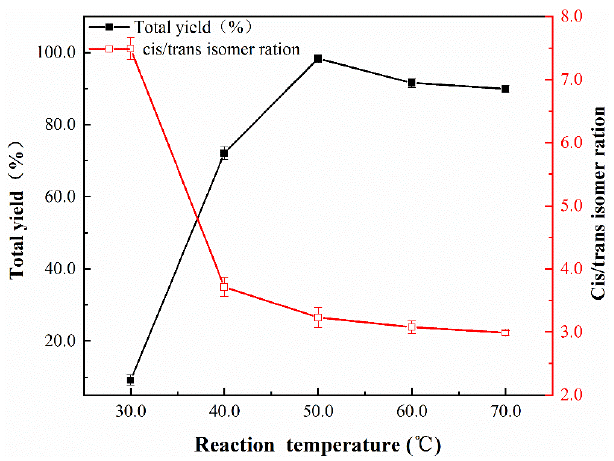
Figure 6. Effect of temperature effect on nano-Fe/Pd catalyst activity in the reaction. Reaction con- ditions: catalyst (10 mg), acetylene (11 mmol), MeOH (20 mL), KI (112 mg), P CO = 1.8 MPa, P total = 4.0 MPa, t = 6 h.